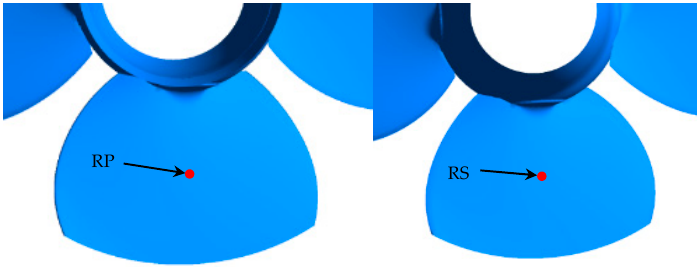
Figure 11. Locations of the recording points.